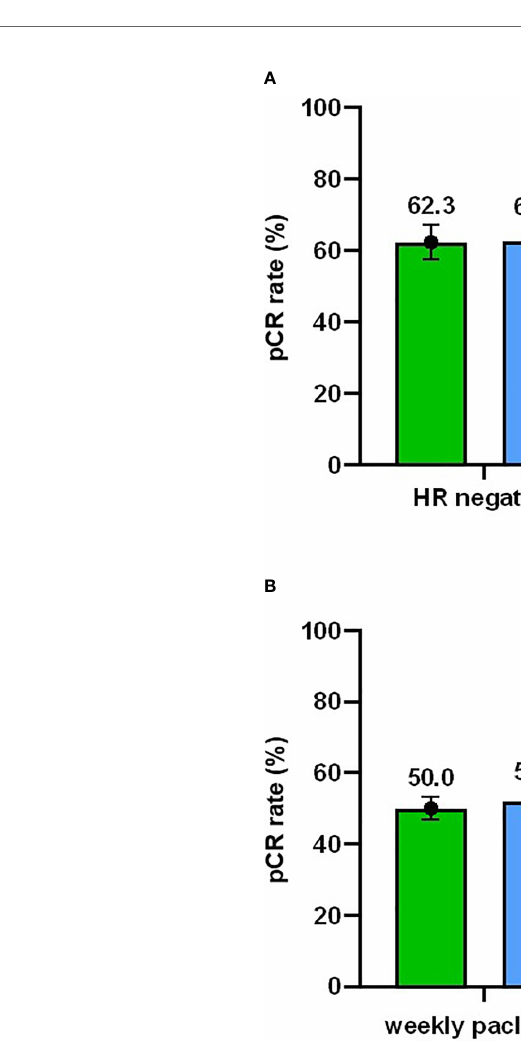
FIGURE 3 | Subgroup analyses. (A) Subgroup analysis of pCR rate with 95% con fi dence interval with respect to the hormone receptor (HR) status. (B) Subgroup analysis of pCR rate with respect to the taxane